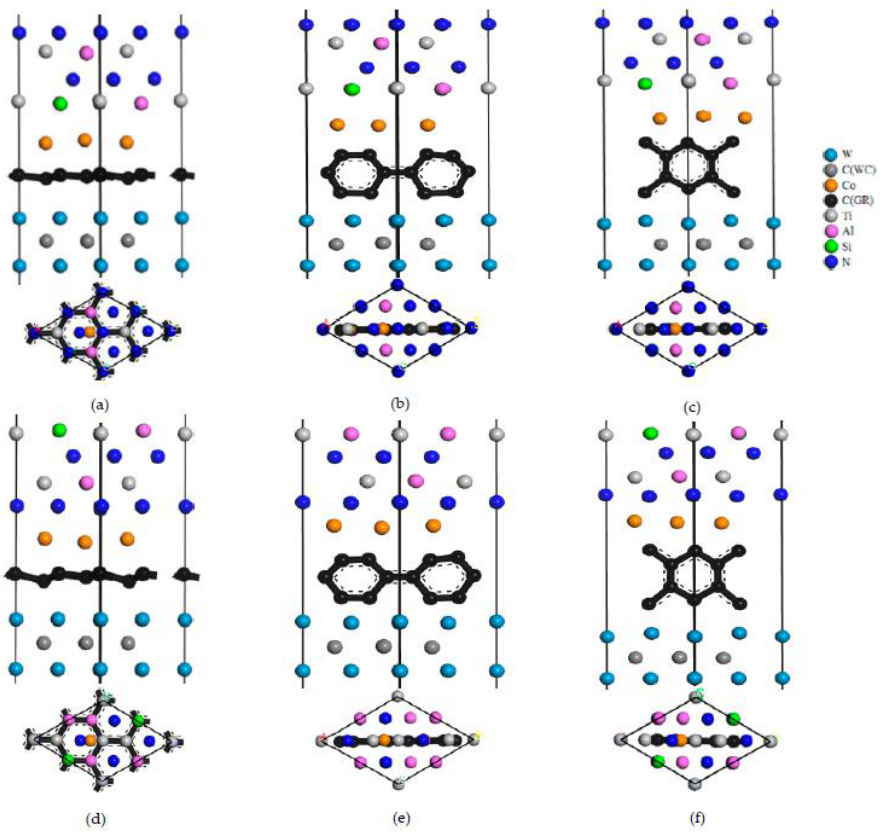
Figure 7. Interface models of matrix doped with intrinsic graphene: ( a ) TiAlSiN Si /WC/msGR/Co; ( b ) TiAlSiN Si /WC/acGR/Co; ( c ) TiAlSiN Si /WC/zzGR/Co; ( d ) TiAlSiN N /WC/msGR/Co; ( e ) TiAlSiN N /WC/acGR/Co; ( f ) TiAlSiN N /WC/zzGR/Co. Four interface models, TiAlSiN Si /WC/svGR/Co, TiAlSiN Si /WC/tdGR/Co, TiAlSiN N /WC/svGR/Co, and TiAlSiN N /WC/tdGR/Co, with defective graphene